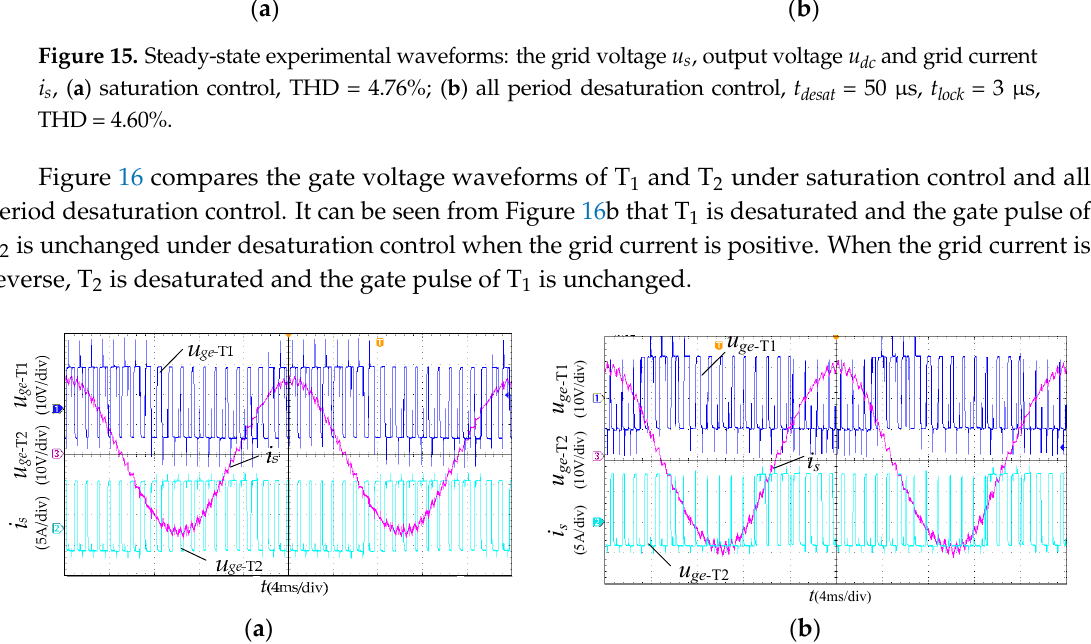
Figure 16. Steady-state experimental waveforms: the gate voltages u ge of the T 1 and T 2 and the inductor current, ( a ) saturation control; ( b ) all period desaturation control, t desat = 50 µ s, t lock = 3 µ s.